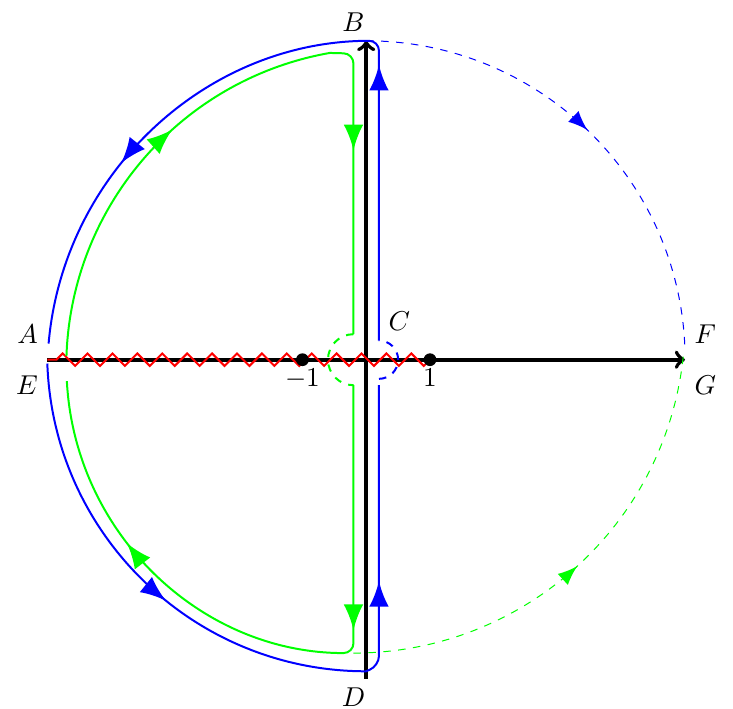
Figure 3 . dS double trumpet continuations from AdS double